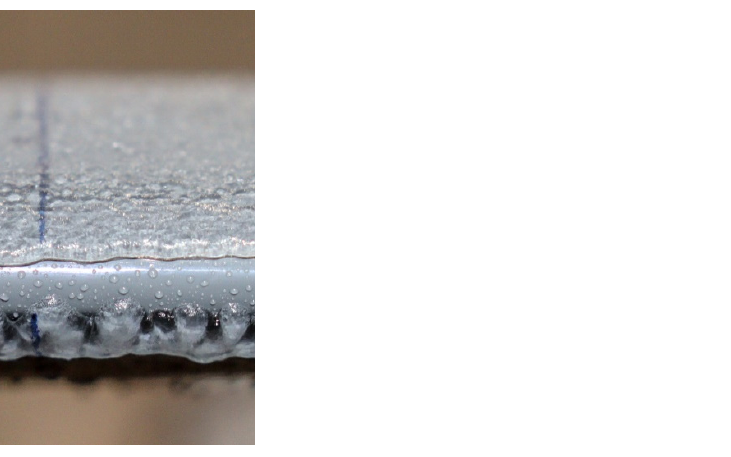
Figure 2. Closeup of the leading-edge after 4 min of ice accretion with active parting strip heating.